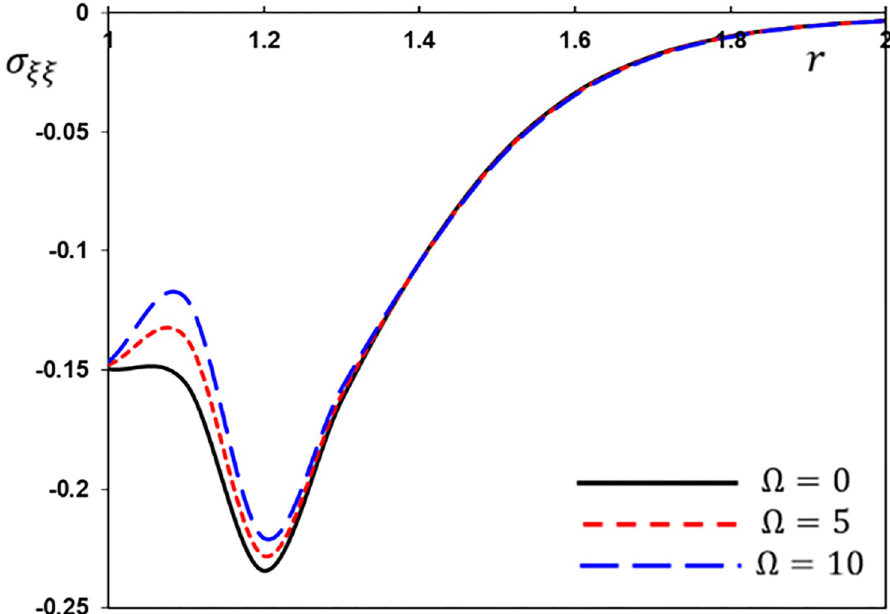
Fig 8. The hoop stress variation σ ξξ for different values of the rotation speed O